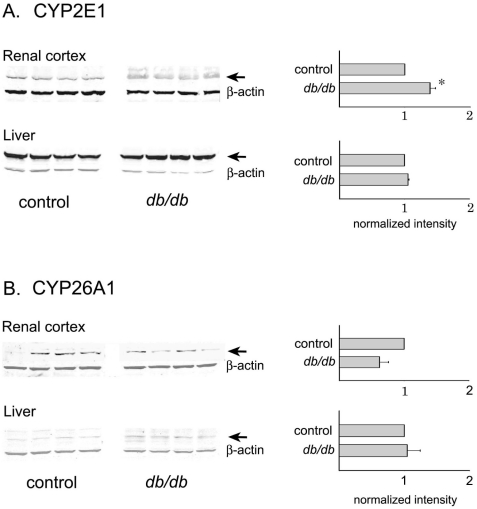
Western immunoblots of CYP2E1 and CYP26A1.Total tissue extracts were prepared from renal cortex and liver of 3-month diabetic and age-matched control mouse kidneys. An equal amount of protein (50 µg/lane) was used for all animals, and representative control (lanes 1–4) and db/db (lanes 5–8) tissue extracts are shown on the left. Densitometric quantitation of 7 control and 7 db/db kidneys and livers are shown on the right. Due to group differences in the expression level of β-actin caused by diabetes, results were not normalized to the loading control. Student's t-test: * p<0.02.